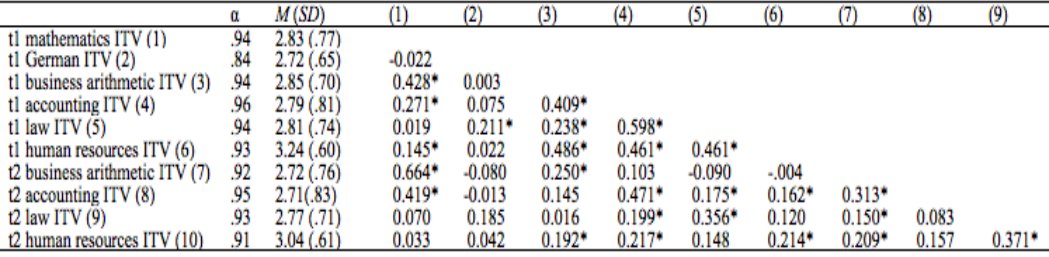
Internal Consistency, Descriptive Statistics, and Latent Bivariate Correlations Across All Intrinsic Task Values